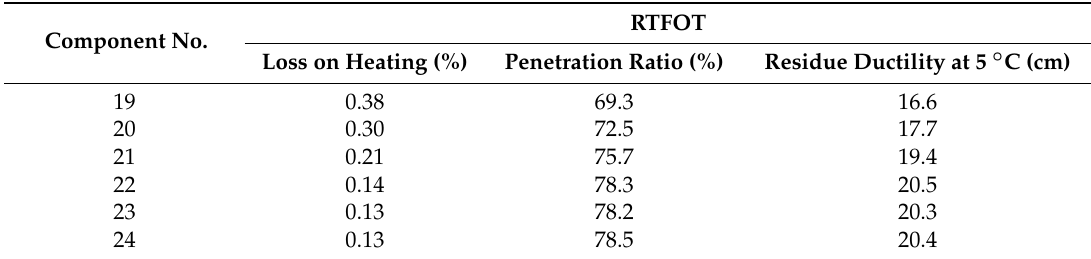
Table 4. The anti-aging performance of SBS-modified bitumen with different BTH content. RTFOT Component No. Loss on Heating (%) Penetration Ratio (%) Residue Ductility at 5 ◦ C